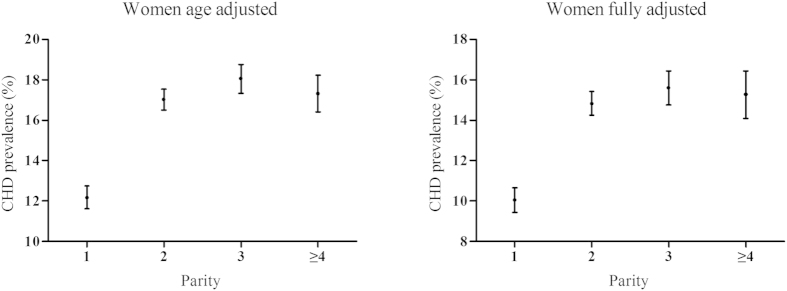
Age-adjusted and fully-adjusted CHD prevalence (95% confidence interval) by parity in Chinese women.